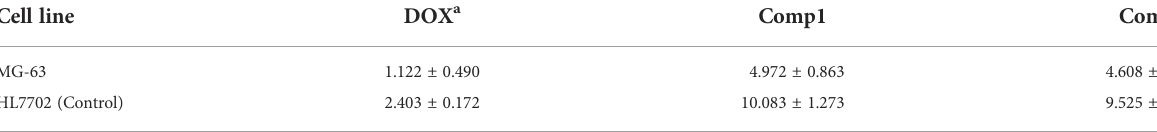
TABLE 2 In vitro anticancer activity (IC 50 in m M) of b - Carboline-3-carboxylic acid